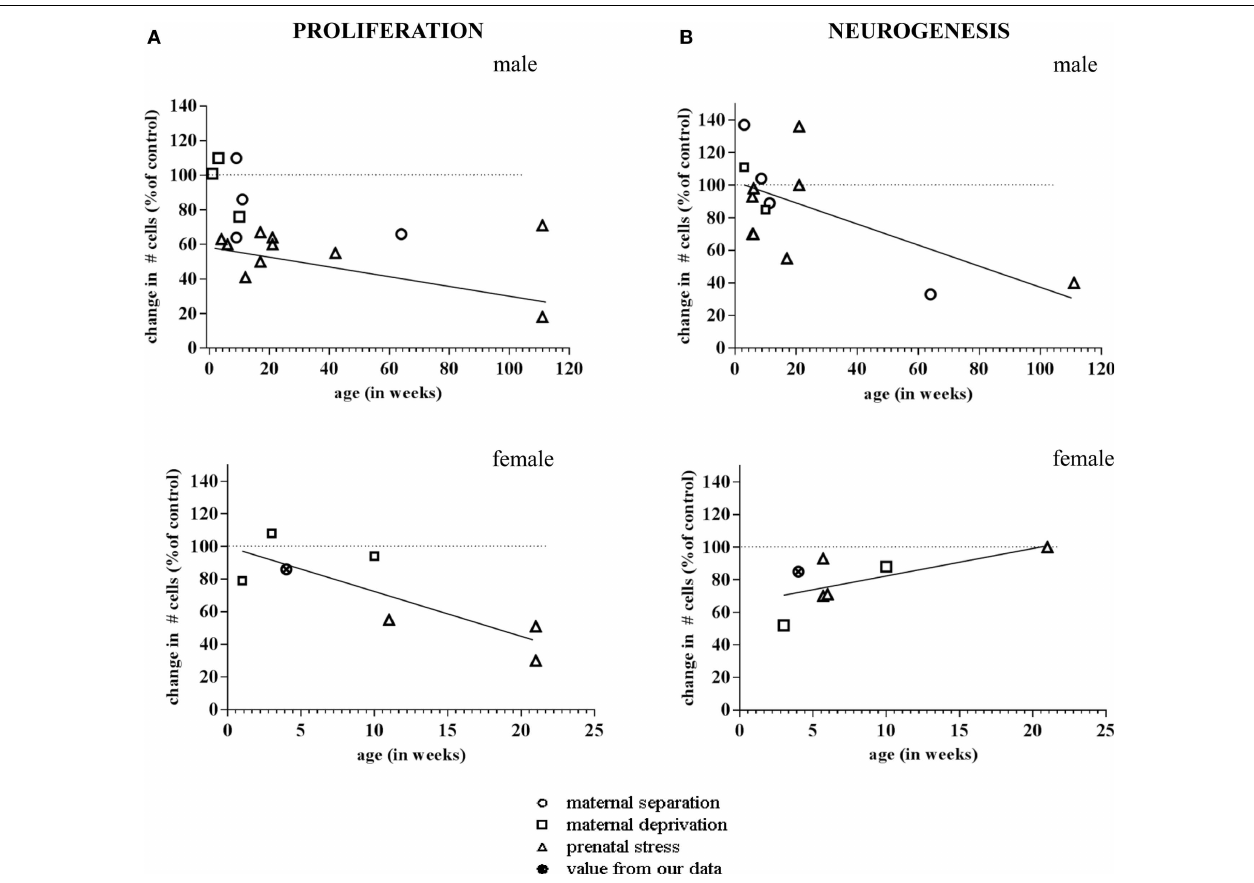
of DCX-positive cells was observed. Overall, this resulted in a negative correlation between the effect of early life stress on neurogenesis and the age at which these effects were apparent. In female rats (bottom), we observed a correlation in the opposite direction.The data points are based on the references summarized in Table 1 .The one data-point depicted by the filled symbol in the graphs of the females represents the percentage change found in the pilot study described in Figure 4 (not incorporated in Table 1 ).The striped horizontal line in the graphs indicates the control condition (i.e., the non-stressed groups mentioned in the same publications) against which the number of cells in the stress groups was expressed.The drawn line indicates the best fit for the linear